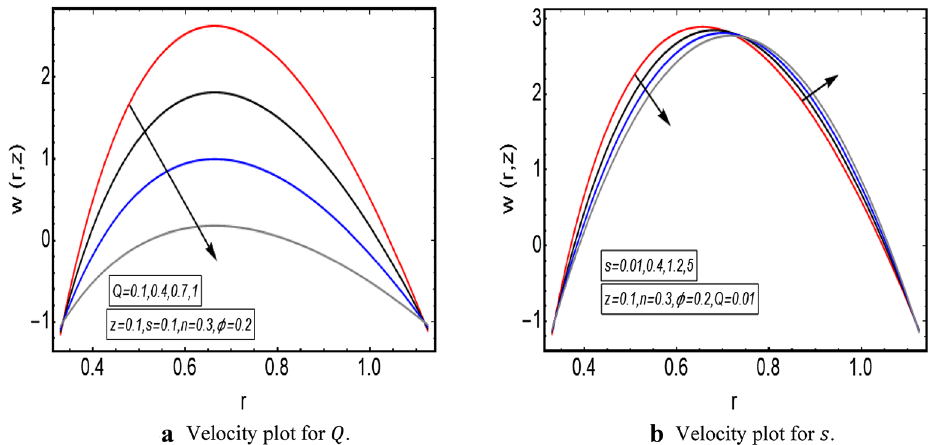
Figure 2. ( a ) Velocity plot for Q . ( b ) Velocity plot for s .